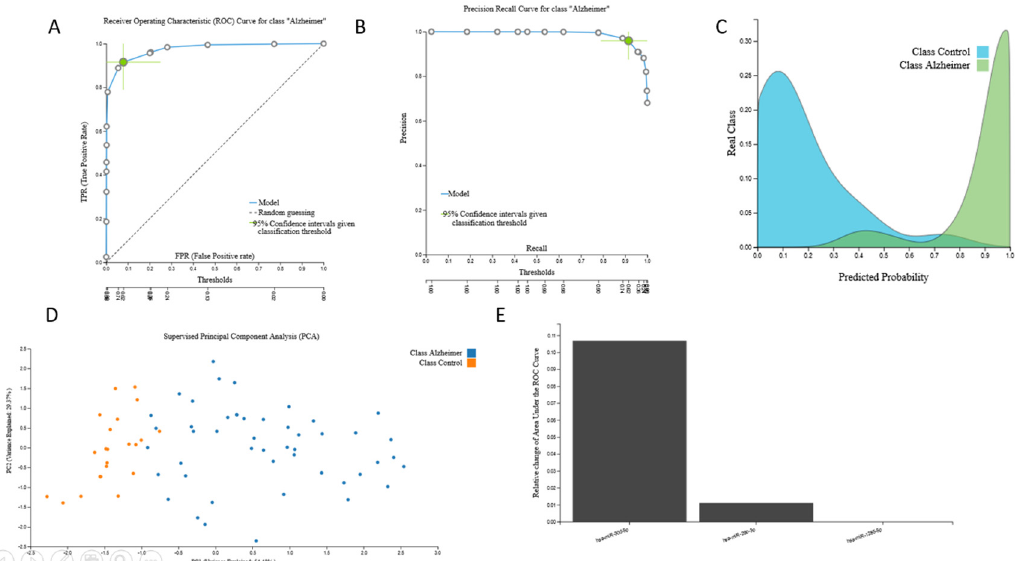
Figure 2. miRNA ‐ transcriptomic signature. The 506 ‐ feature miRNA ‐ transcriptomic dataset signature performance, selected predictors and model inspection: ( A ). Receiver Operating Characteristic (ROC) Curve for AD class, ( B ). Precision ‐ recall plot, ( C ). Probabilities density plot, ( D ). Supervised Principal Component Analysis plot depicting discrimination between AD patients and age–sex matched cognitively healthy individuals, ( E ). Cumulative feature importance plot of the 3 miRNA predictors of the signature.